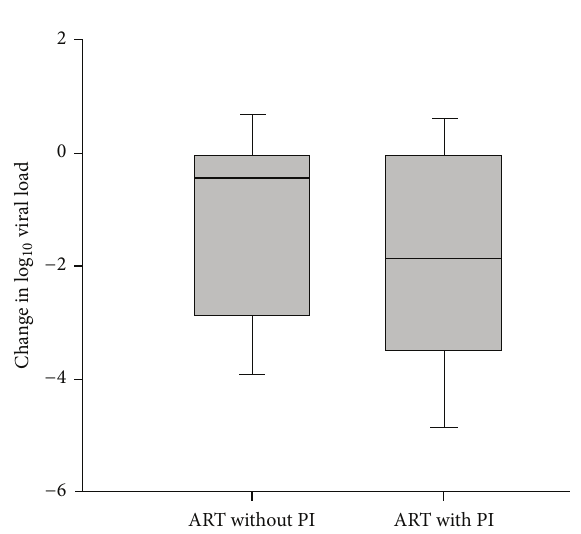
Figure 1: Change in viral load during pregnancy for women receiving ART with and without a protease inhibitor. Shaded area represents one standard deviation from the mean, which is denoted as the black line. Whiskers represent two standard deviations from the mean. The change in log 10 viral load is significantly greater for ART with a protease inhibitor (PI) using the Student-Newman- Keuls test, 𝑝 < 0.001